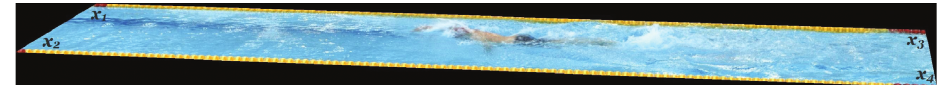
Figure 4: Lane extraction and mask application taking into account the four points: x 1 , x 2 , x 3 , and x 4 . The metric coordinates of these points are known and pixel coordinates are calculated using the calibration results. Swimming Championships in Limoges, France, April 2015.